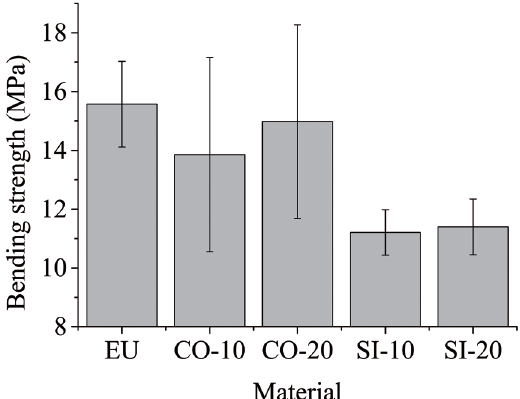
Figure 3: Histogram of the mean values for bending strength (MOR). Bars indicate standard deviation